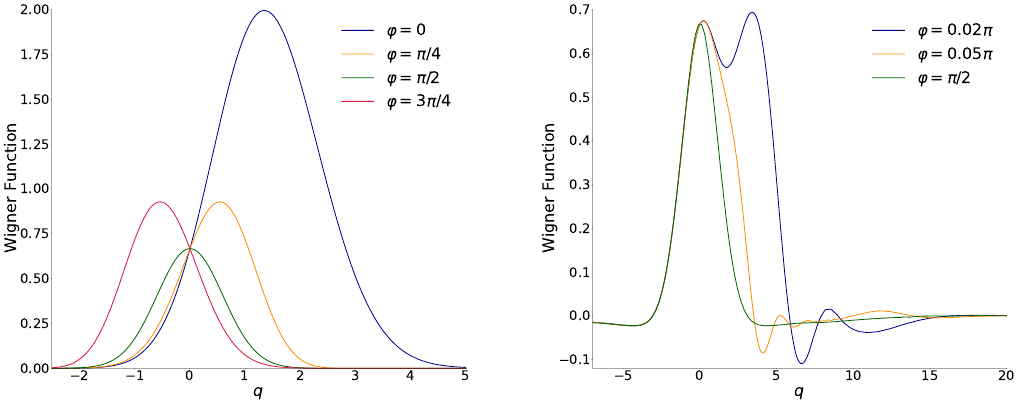
Figure 8. 2D sections of the Wigner function W ( q ,0 ) for some values of the phase ϕ . Left: for (cid:104) ˆ n (cid:105) = 1. Right: for (cid:104) ˆ n (cid:105) =